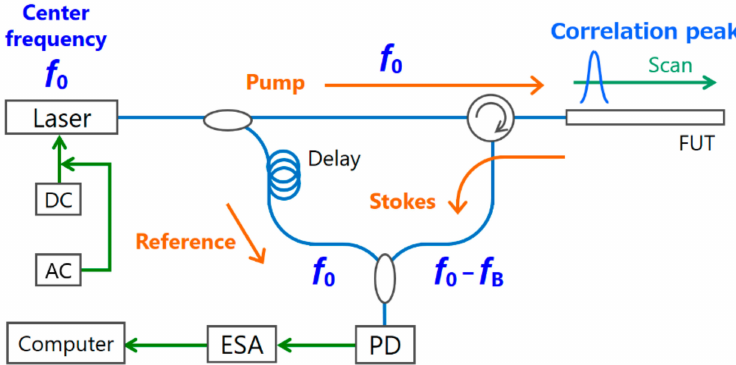
Figure 1. Conceptual schematic of BOCDR. AC, alternating current; DC, direct current; ESA, electrical spectrum analyzer; FUT, fiber under test; PD,